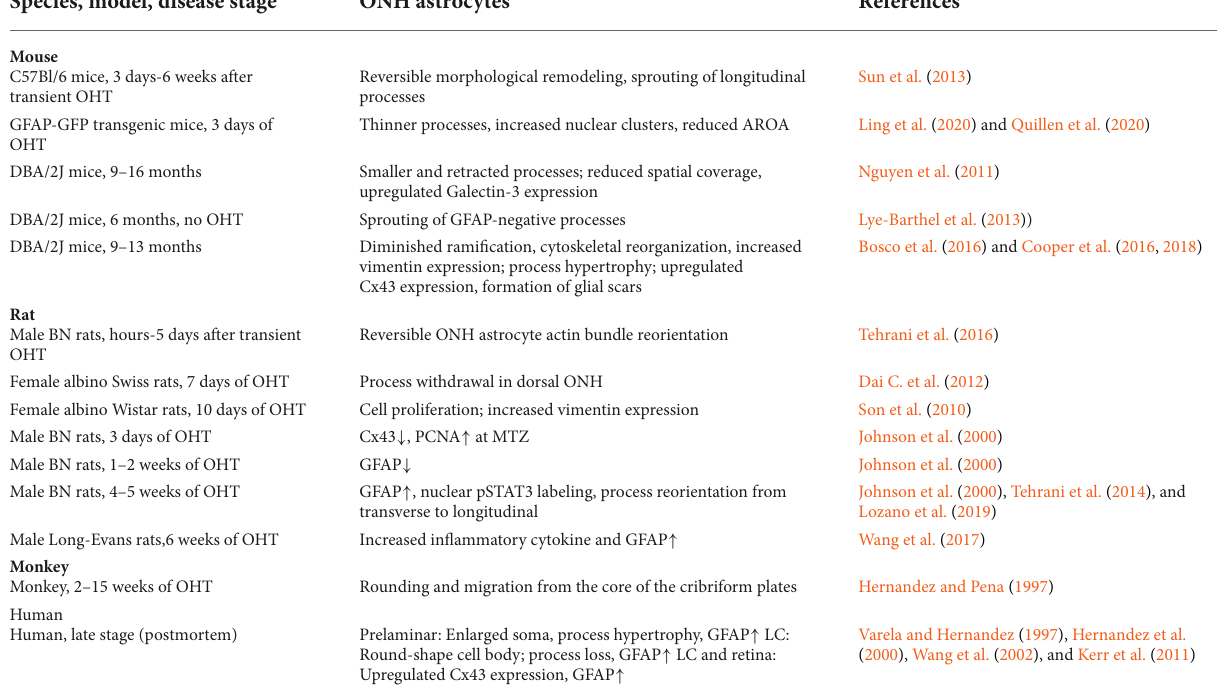
TABLE 3 ONH astrocytes changes in